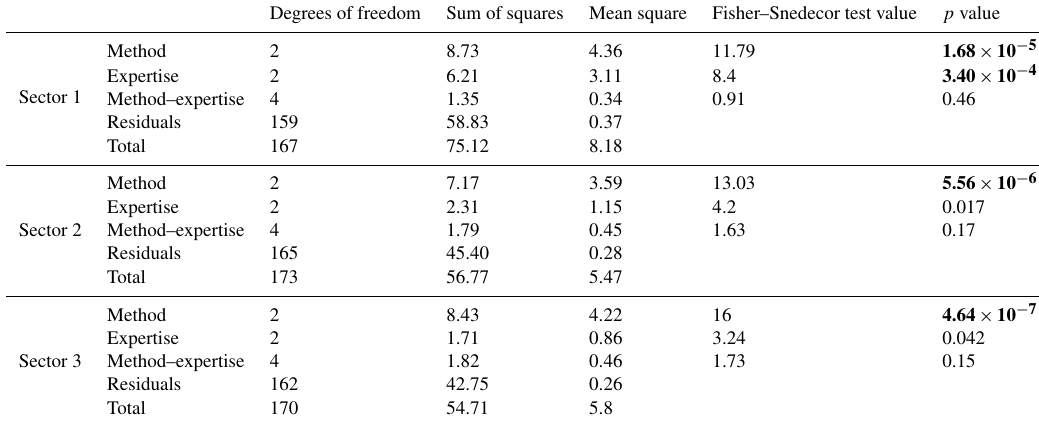
Table 13. Results of ANOVA: influence of the level of expertise and the choice of the method on the level of rockfall hazard for the three sectors. The bold values highlight the significantly influencing factors, for which the p values are lower than 1%.